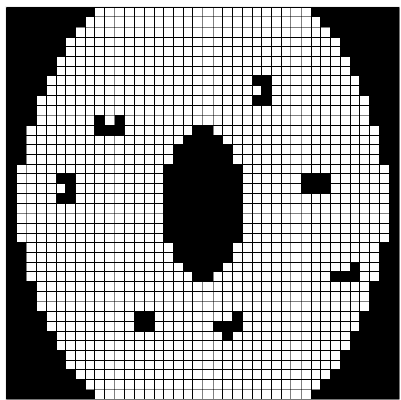
Figure 2. Inspection Motion Spatial Raster Map.